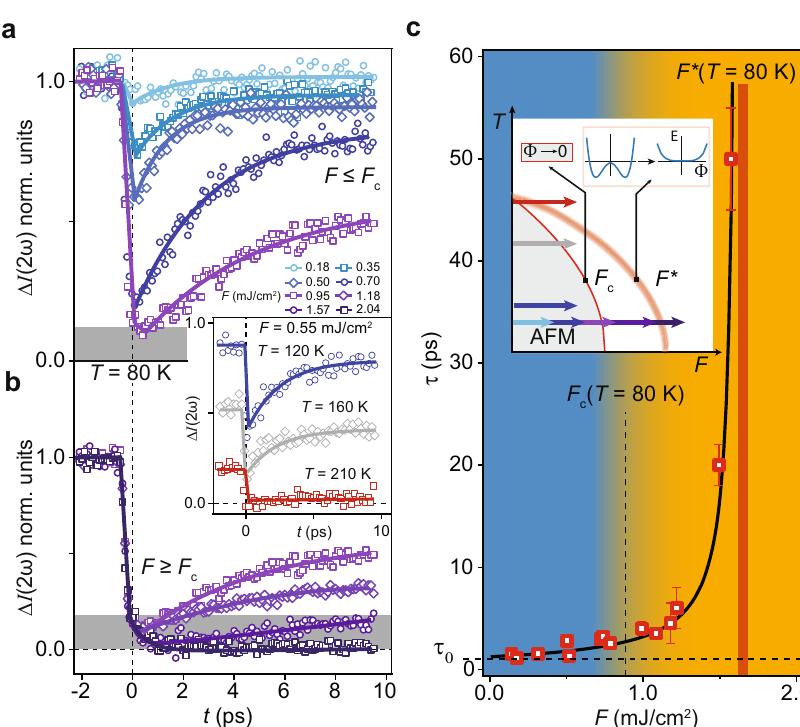
Fig. 3 Out-of-equilibrium critical dynamics of the magnetic order parameter. Transient change in second harmonic generation (SHG) intensity Δ I (2 ω ) acquired at T = 80 K for select fl uences ( F ) a below and b above the critical fl uence F c . The height of the gray bar denotes the excess electric-quadrupole (EQ) SHG intensity at t = 0 as discussed in the Results section “ Temporal evolution of the SHG response ” . Inset shows analogous data acquired at fi xed F = 0.55 mJ/cm 2 for different temperatures. Solid lines are fi ts of the recovery to a single exponential function plus a constant determined by the long time offset of the SHG intensity. c Plot of fi tted exponential relaxation times, τ , versus fl uence superposed with a fi t to the function τ ¼ τ 0 ð 1 (cid:2) F = F (cid:4) Þ (cid:2) 1 , with τ 0 fi xed to 1.2 ps as described in the Discussion section. The values of F F * (orange vertical bar) at c (dashed vertical line and blue-orange background) and T = 80 K based on the data in panels a , b and the fi t (black line) respectively are explicitly marked. The decoupling of the divergence in magnetic correlation length (de fi ned by F c ) from the divergence in relaxation time (de fi ned by F * ) is illustrated in the inset based on the data in panels a and b . The arrows are color-coded in correspondence to the curves in panels a and b and point to the location in the out-of-equilibrium phase diagram being accessed. Schematics show the out-of-equilibrium free energy landscape after doublon decay based on the Langevin theory described in the text. Vertical error bars represent the uncertainty in τ obtained from fi ts to the exponential function shown in panels a , b